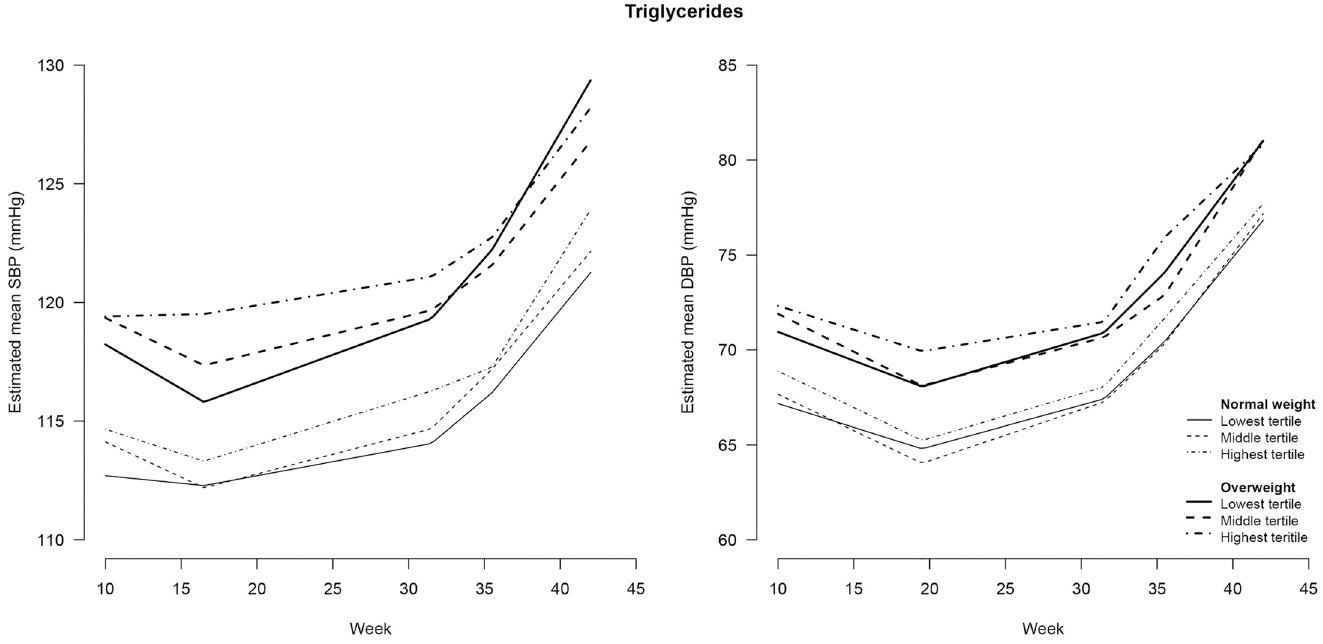
Fig 3. Blood pressure during pregnancy stratified for maternal weight status and tertiles of triglycerides # . SBP = systolic blood pressure; DBP = diastolicblood pressure. # triglycerideswere determined in non-fastingblood samplesdrawn at a medianof 13 (IQR = 12–14)weeks of gestation.